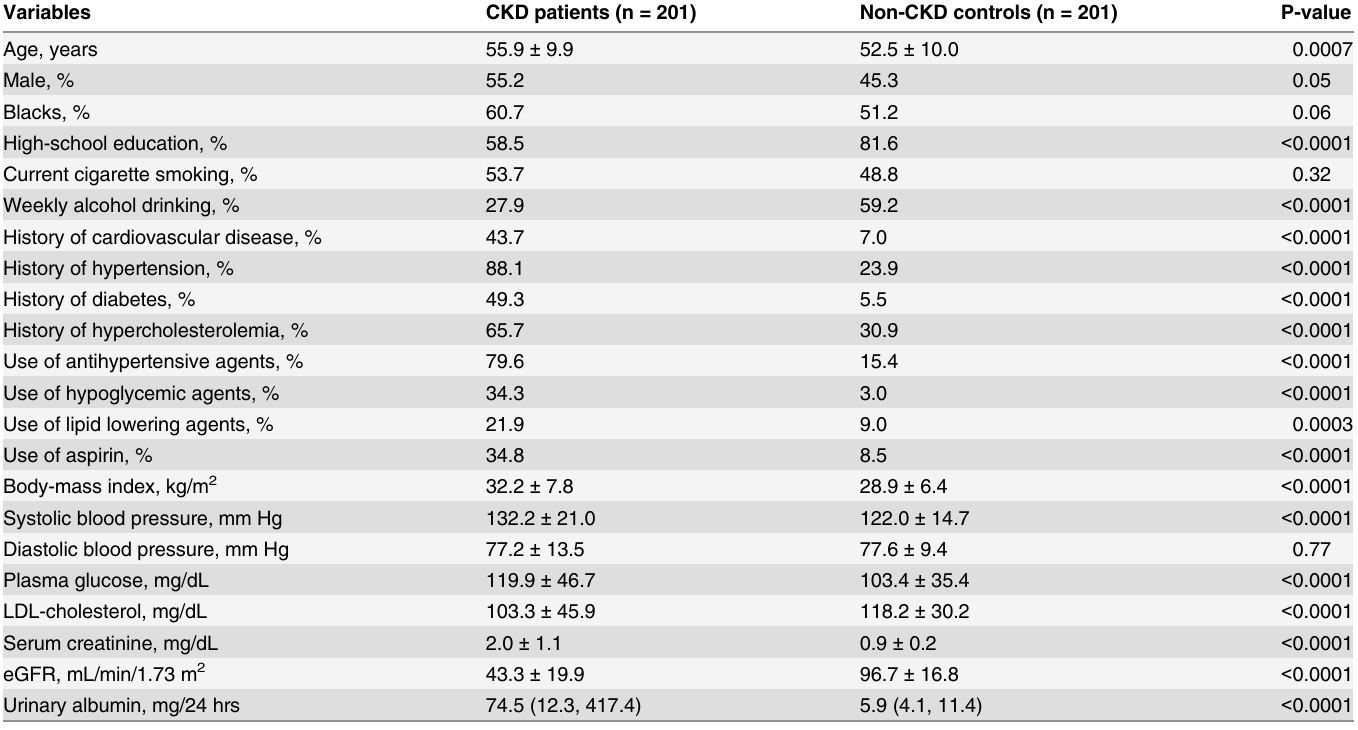
Table 1. Characteristics of 201 Patients with Chronic Kidney Disease and 201 Controls without Chronic Kidney